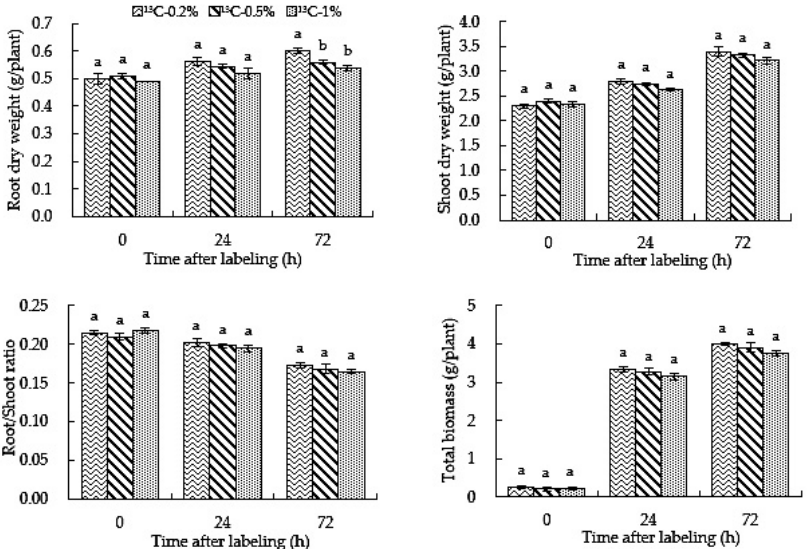
Figure 5. High root-zone 13 CO 2 affects the accumulation of biomass in roots and shoots of oriental melon. Standard errors (SEs) of the means are represented by error bars. Different letters in the same row indicate significance at the 0.05 level among treatments.